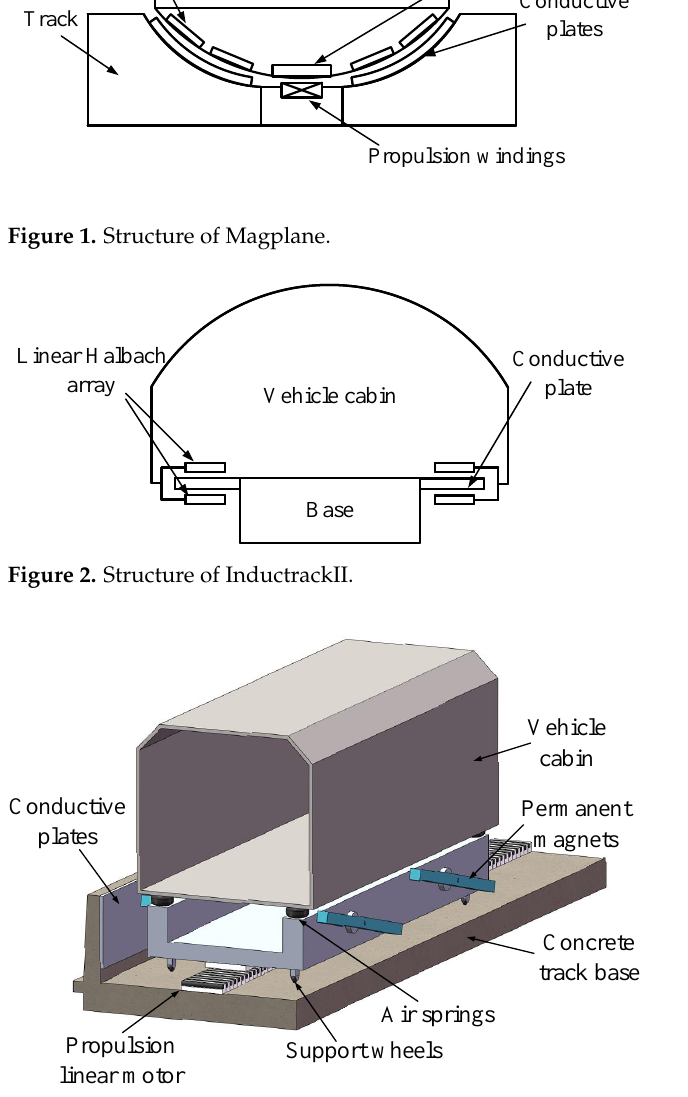
Figure 3. Structure of